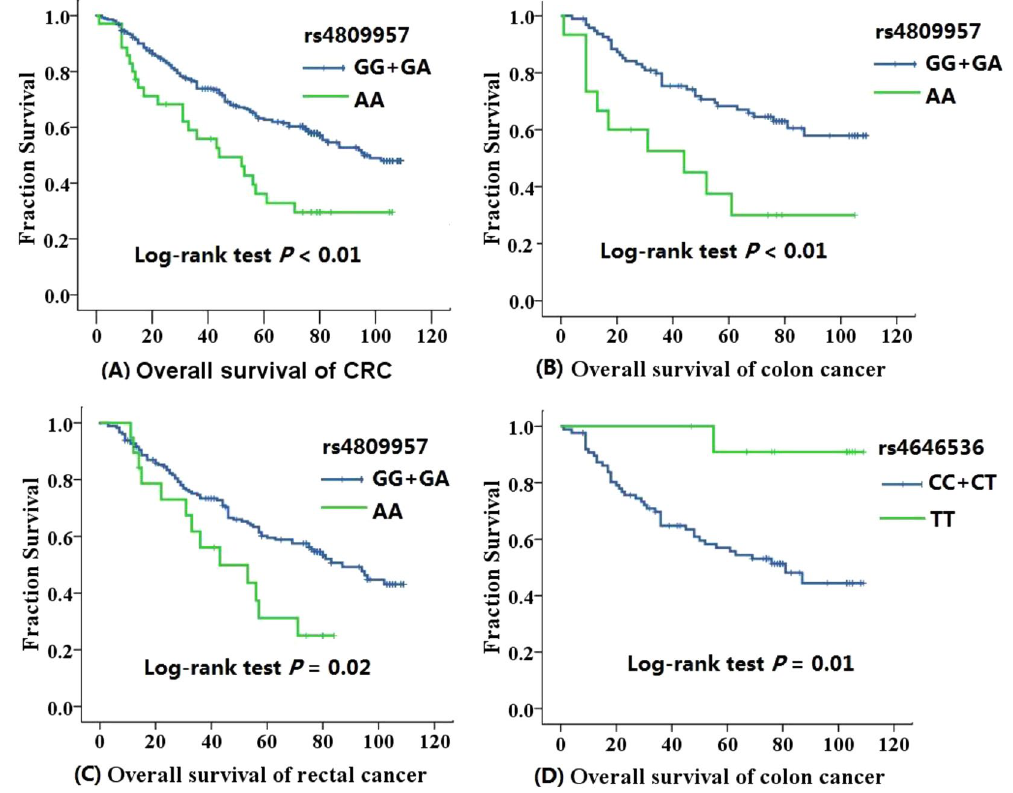
Figure 1. Kaplan-Meier curves of overall survival in CRC (colon and rectal cancer). for CYP24A1 rs480957 and CYP27B1 rs4646536 polymorphisms (( A) . CYP24A1 rs480957 in CRC, ( B ) CYP24A1 rs480957 in colon cancer, ( C ) CYP24A1 rs480957 in rectal cancer, ( D ) CYP27B1 rs4646536 in colon